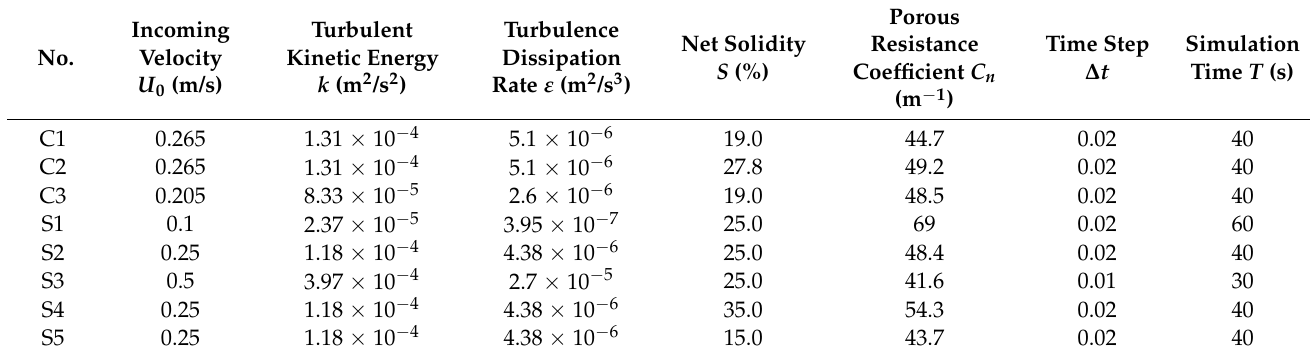
Table 1. Parameters of OpenFOAM